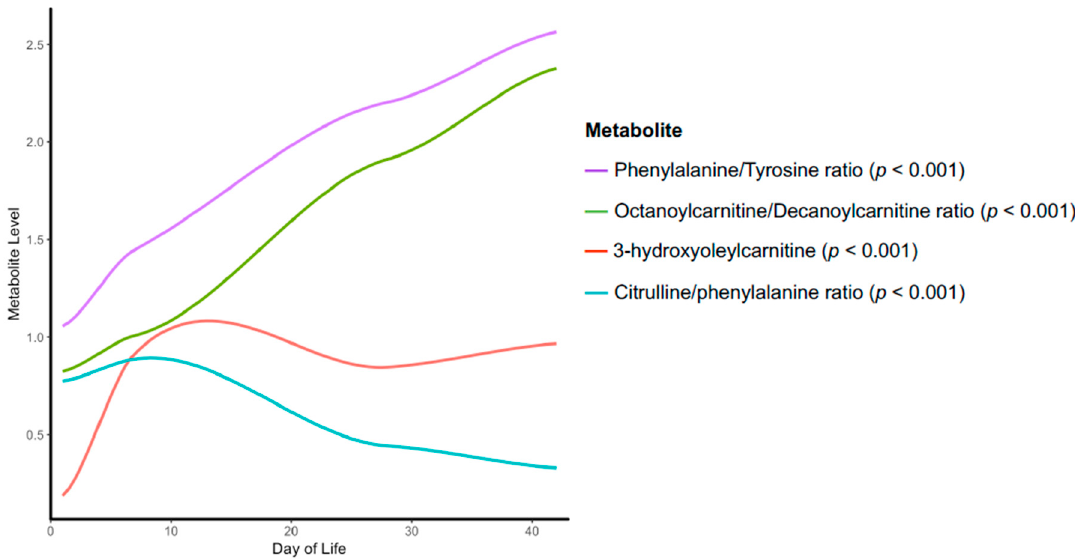
Figure 2. Loess curve depicting time trend of those metabolite relationships that are statistically significant upon longitudinal modeling and Bonferroni correction .